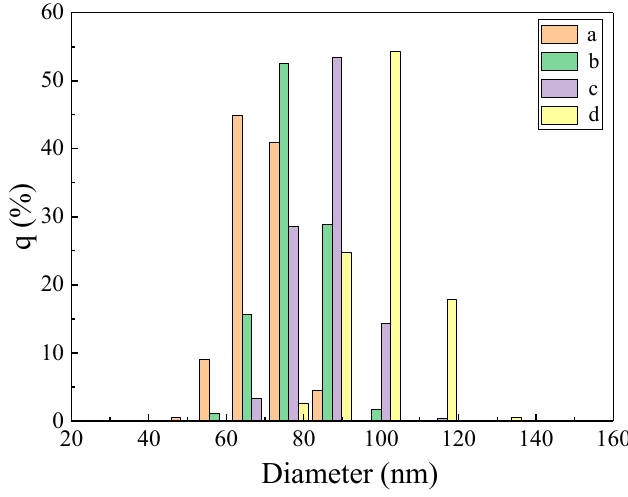
Figure 6. Particle size distribution. (a) 1.0 nmol/L Pb 2+ Apt + 88.0 μ g/mL AgCOF + 0.87 mmol/L AgNO 3 + 6.67 mmol/L C 6 H 5 Na 3 O 7 ; (b) a + 0.067 nmol/L Pb 2+ ; (c) a + 0.23 nmol/L Pb 2+ ; (d) a + 0.57 nmol/L Pb 2+ .